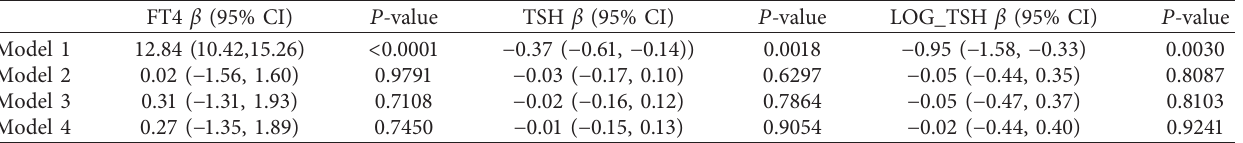
Table 2: Multivariate regression analyses of factors associated with upper limb muscle strength (weighted).